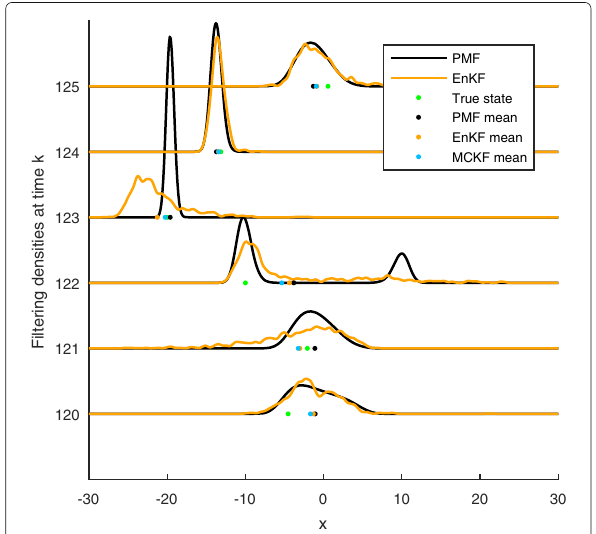
Fig. 5 Consecutive filtering densities p ( x k | y 1: k ) by PMF, EnKF, and MCKF for k = 120, ... ,125. Also illustrated are the mean values of the respective densities and the true